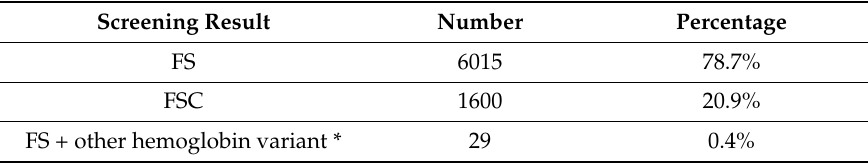
Table 2. Screen positive babies between 1995 and